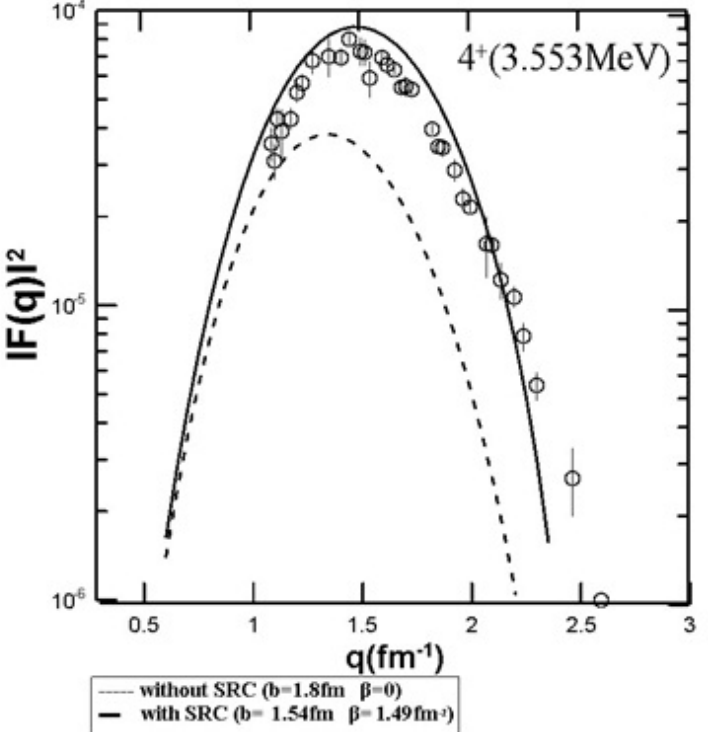
Fig. 5: Inelastic Coulomb 4 C form factors for the transition to the 14 + (3.553 MeV) state. The dashed and solid curves are the calculated 4 C form factors without and with the inclusion of the effect of the SRC, respectively. The open circle symbols are those of the experimental data taken from